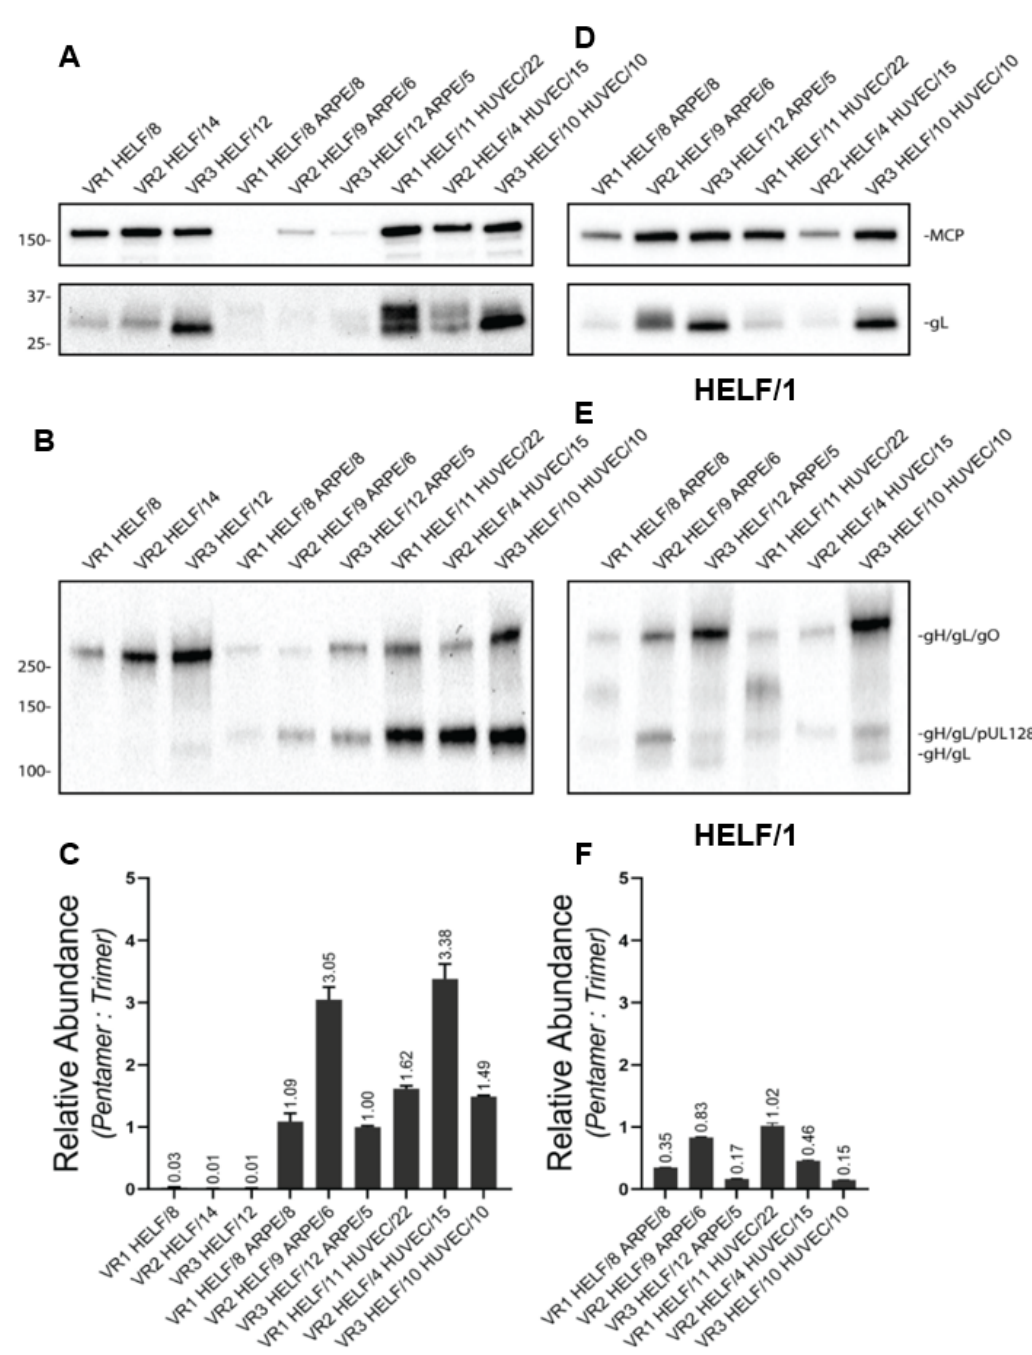
Figure 5. Immunoblot analysis of: ( A – C ) cell-free VR#1 to VR#3 virus preparations on human fibroblasts (HELF), epithelial (ARPE-19) and endothelial cells (HUVEC); and ( D – F ) the same three virus preparations after a single back passage from ARPE-19 and HUVEC to HELF. ( A , D ): reducing conditions. ( B , E ): non-reducing conditions. ( C , F ): PC/TC ratio.